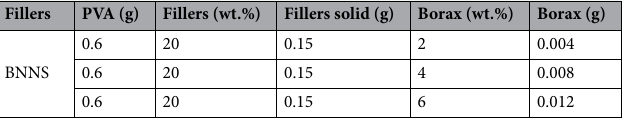
Table 3. Concentrations of BNNS, PVA, and borax in nanocomposites.